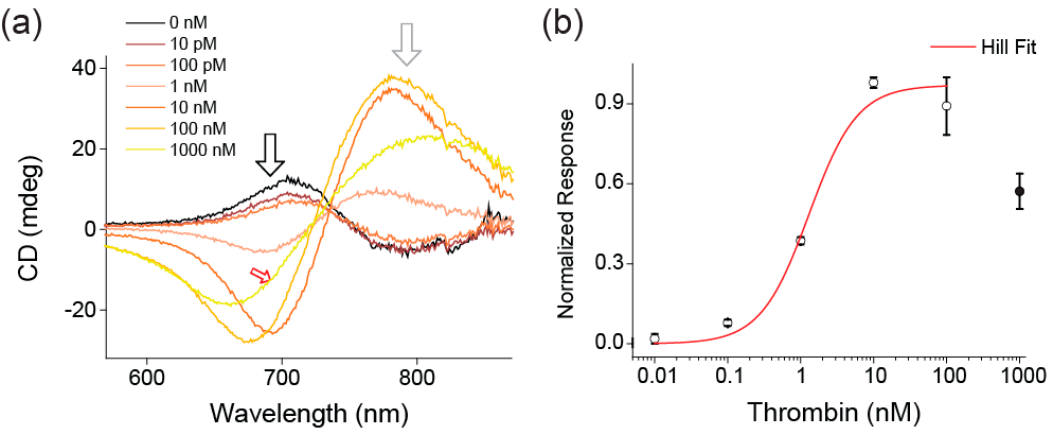
Figure 2. Detection of thrombin with plasmonic circular dichroism (CD) from the metamolecules. ( a ) CD spectrum of 100 pM metamolecule in the presence of different concentrations of thrombin. As the concentration of thrombin increases, the CD spectrum switches from right-handed (black line) to left-handed (red line). At thrombin concentrations above 100 nM (1000 nM, red arrow), the signal strength decreases as the thrombin molecules bind to each arm of the metamolecule rather than being sandwiched between two arms. To reduce the noise, all signals were measured with 10 nm spectral windows and the difference between two frequency windows (black and grey arrows) was calculated. ( b ) Normalized response-concentration data (black circles) with Hill equation fit (red line). The Hill coefficient obtained through the fit was 1.3 ± 0.3 and K d = 1.4 nM. The normalized response values were obtained by subtracting the values at the extremes (black and grey arrows of Figure 2a) and normalizing it by the value at 10 nM.